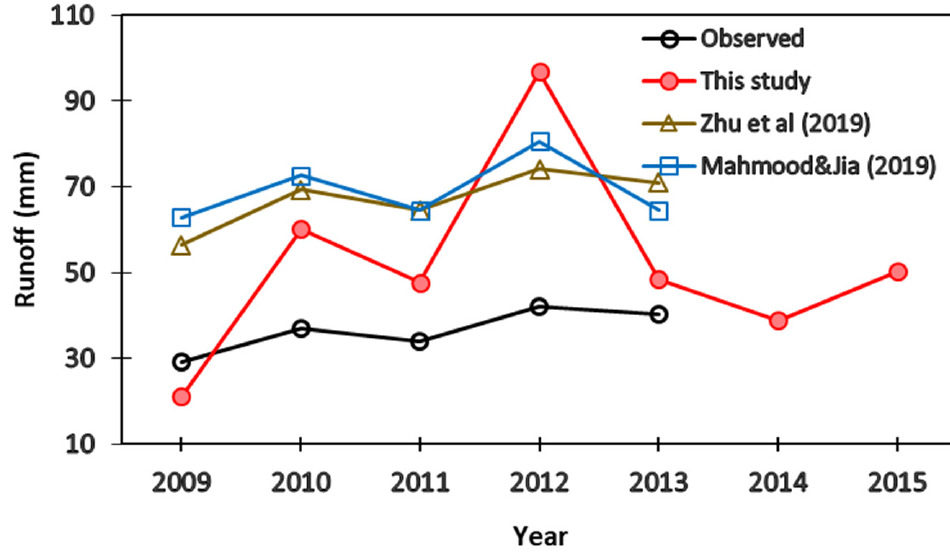
Figure 11. Comparison of simulated runoff in the Lake Chad Basin by different studies.